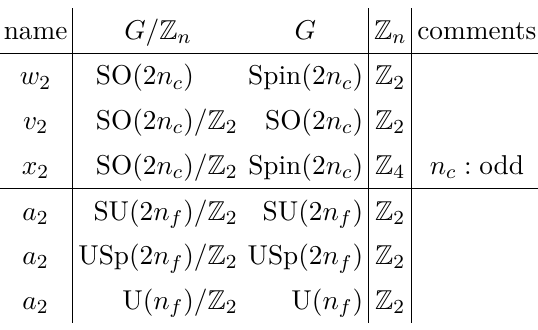
Table 3 . The names we use for the obstruction classes ∈ H 2 ( X, Z n ) controlling whether a G/ Z n bundle on X lifts to a G